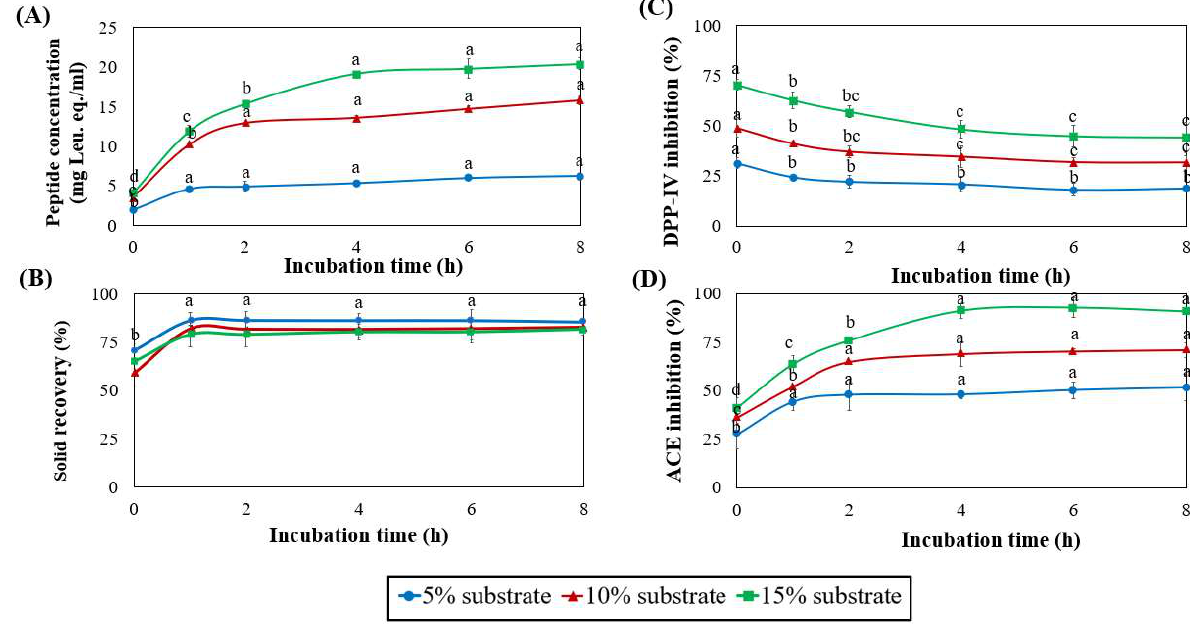
Figure 5. Peptide concentration ( A ), solid recovery ( B ), DPP-IV ( C ), and ACE ( D ) inhibitory activities of hydrolysate prepared from various sericin concentrations at 5, 10, and 15 g/100 mL, with 5% (E/S) of neutrase concentration, and a hydrolysis time of 0–8 h. The DPP-IV and ACE inhibitory activities were measured in the same dilution volume. Significantly different values within the line ( p < 0.05) are represented by superscript letters (a–d).